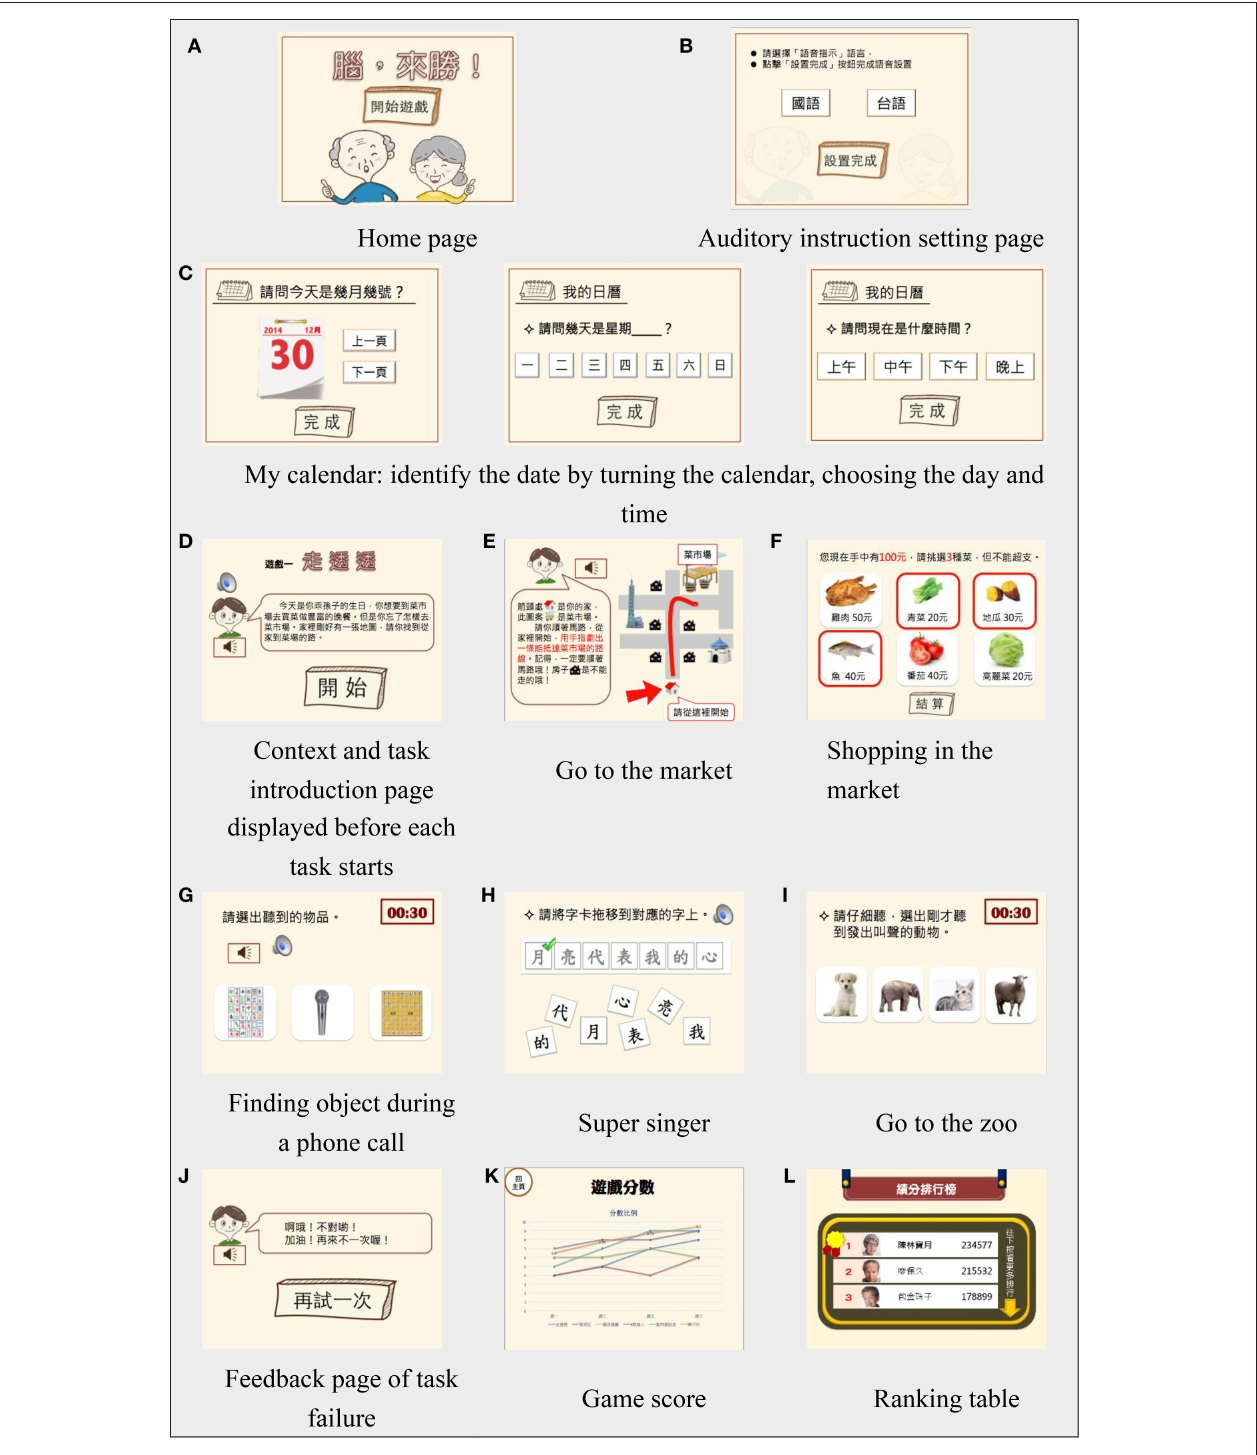
FIGURE 4 | User interface prototype. (A) Home page (B) Auditory instruction setting page (C) My calendar: identify the date by turning the calendar, choosing the day and time (D) Context and task introduction page displayed before each task starts (E) Go to the market (F) Shopping in the market (G) Finding object during a phone call (H) Super singer (I) Go to the zoo (J) Feedback page of task failure (K) Game score (L) Ranking